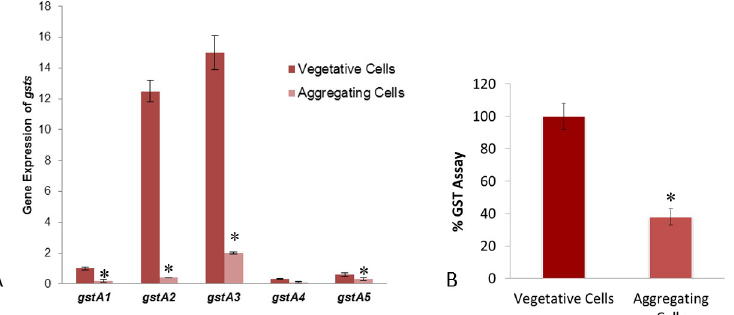
Fig 1. Transcription and Functional Profile of D . discoideum GST isozymes. (A) Quantitative PCR analysis of the gstA1-5 in vegetative and starvation-induced aggregating cells. (B) GSTs activity (CDNB conjugation) in vegetative and aggregating cells. Histograms represent at least three experiments (n = 3) performed in triplicate (mean ± SD, p < 0.05).